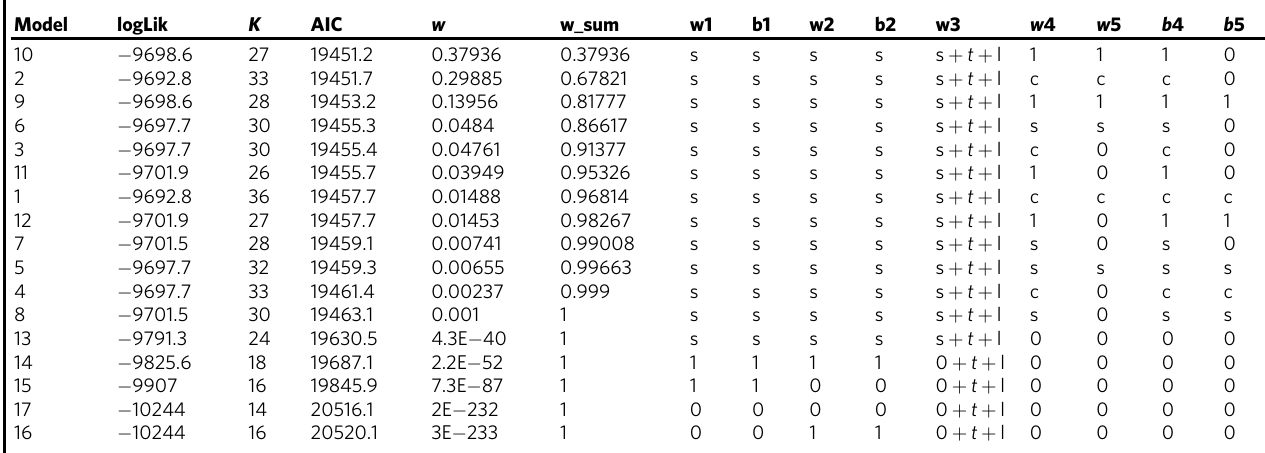
The 17 models we fi tted are here sorted by increasing AIC. The best model is thus at the top (Model 10). For the “ Model fi t ” part of the table (columns 2 to 6), columns show the log likelihood, the number of estimated parameters ( K ), the AIC value, the AIC weight of the model and the cumulative weight. AIC weights estimate the probability for a given model to be the best among the candidate models fi tted.The “ ModelStructure ” partofthetable(columns7to15)indicateswhichmodelparametershavebeenestimated.Modelparametersarede fi nedinmethods.Thesymbol “ 0 ” indicatesthat the model parameter has not been estimated and was thus assumed to be null. The symbol “ 1 ” indicates that a single parameter value was estimated for a given model meta-parameter (see Methods). The symbol ‘‘ s ” indicates that one parameter value for each sex was estimated (hence the value of the model parameter can change according to the sex). The symbol “ c ” indicates that one parameter value foreach capture methodwas estimated. For the modelparameter w 3, we considerthat it candepend onthe sex ( “ s ” ),birth cohort ( “ t ” ) and living region ( “ l ” )butwe did notconsider interactions, leading to 14 estimates for w3 for “ t + l ” and 16 for “ s ” + t + l". The model averaged estimates are provided in Supplementary Table 1 and all parameter estimates for all 17 models are provided in